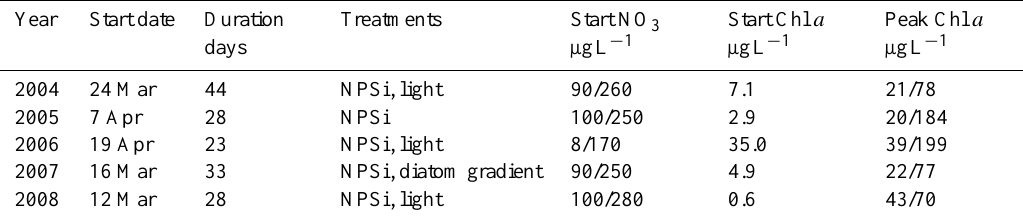
Table 1. Summary of the experimental setup in different years. The treatments were nutrient addition (NPSi), which were additions of nitrogen (N), phosphorus (P), and silicate (Si) in N–P, Si and N–P–Si additions. The light treatment (light) was a low- and high-light treatment, 20 and 90µmolphotonsm − 2 s − 1 , respectively. In 2005 there was only the nutrient addition treatment and in 2007 there cultured diatoms were added in a gradient (diatom gradient). The diatoms added were Thalassiosira levanderi ( ∼ 10µm diameter and was added to a final concentration of 20000, 75000 and 13350cellsL − 1 ) and T. baltica (20–30µm diameter and was added to a final concentration of 2000, 3560 and 13350cellsL − 1 ), two very typical spring bloom species. The start concentration of NO 3 (Start NO 3 ) gives the concentration in µgL − 1 of NO 3 in the control and in the treatments with N addition. The peak Chl a values are the minimum and maximum concentration recorded in the control (no nutrient addition) and in treatments with nutrients added,